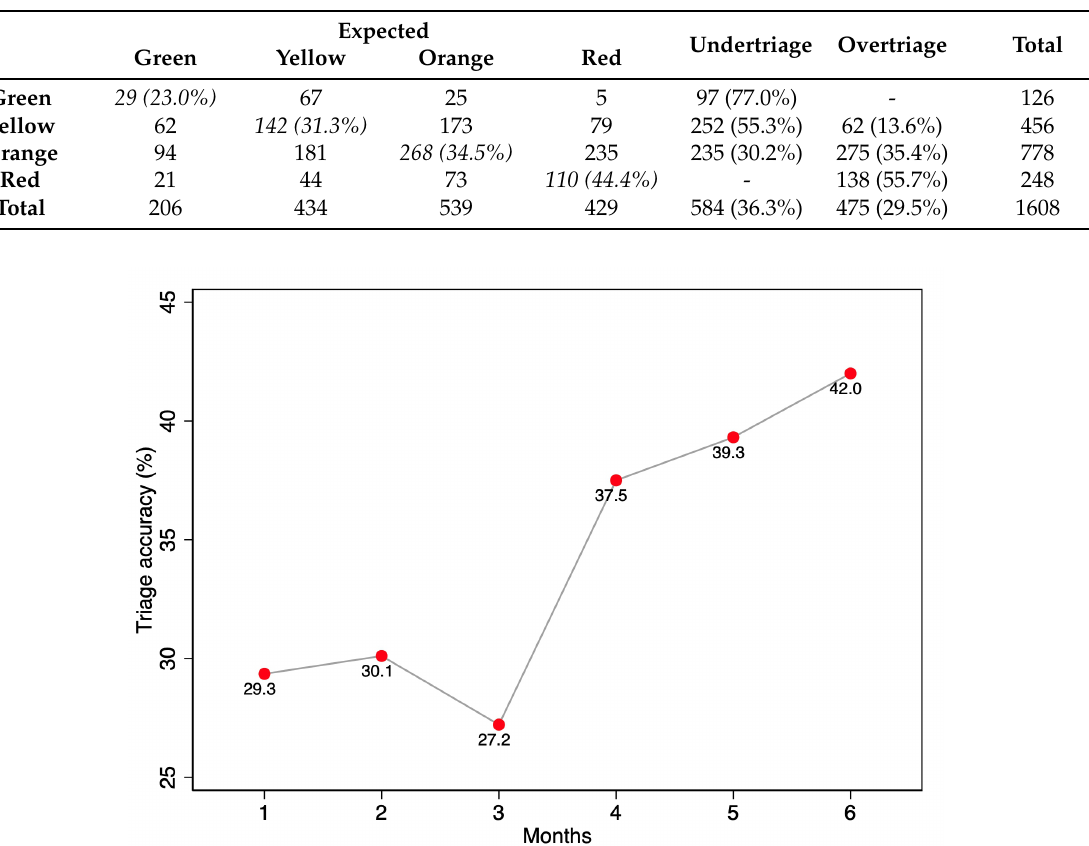
Table 3. Comparison of the triage code originally assigned by local personnel and the code retrospec- tively obtained by researchers. The results in italics represent the number of correct triages performed by local personnel; those above and below them identify the percentage of over- and undertriage per category, respectively.